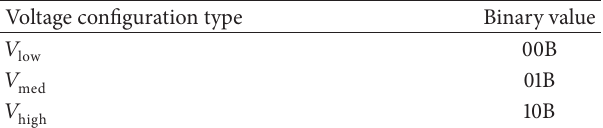
Table 1: The binary voltage configuration.